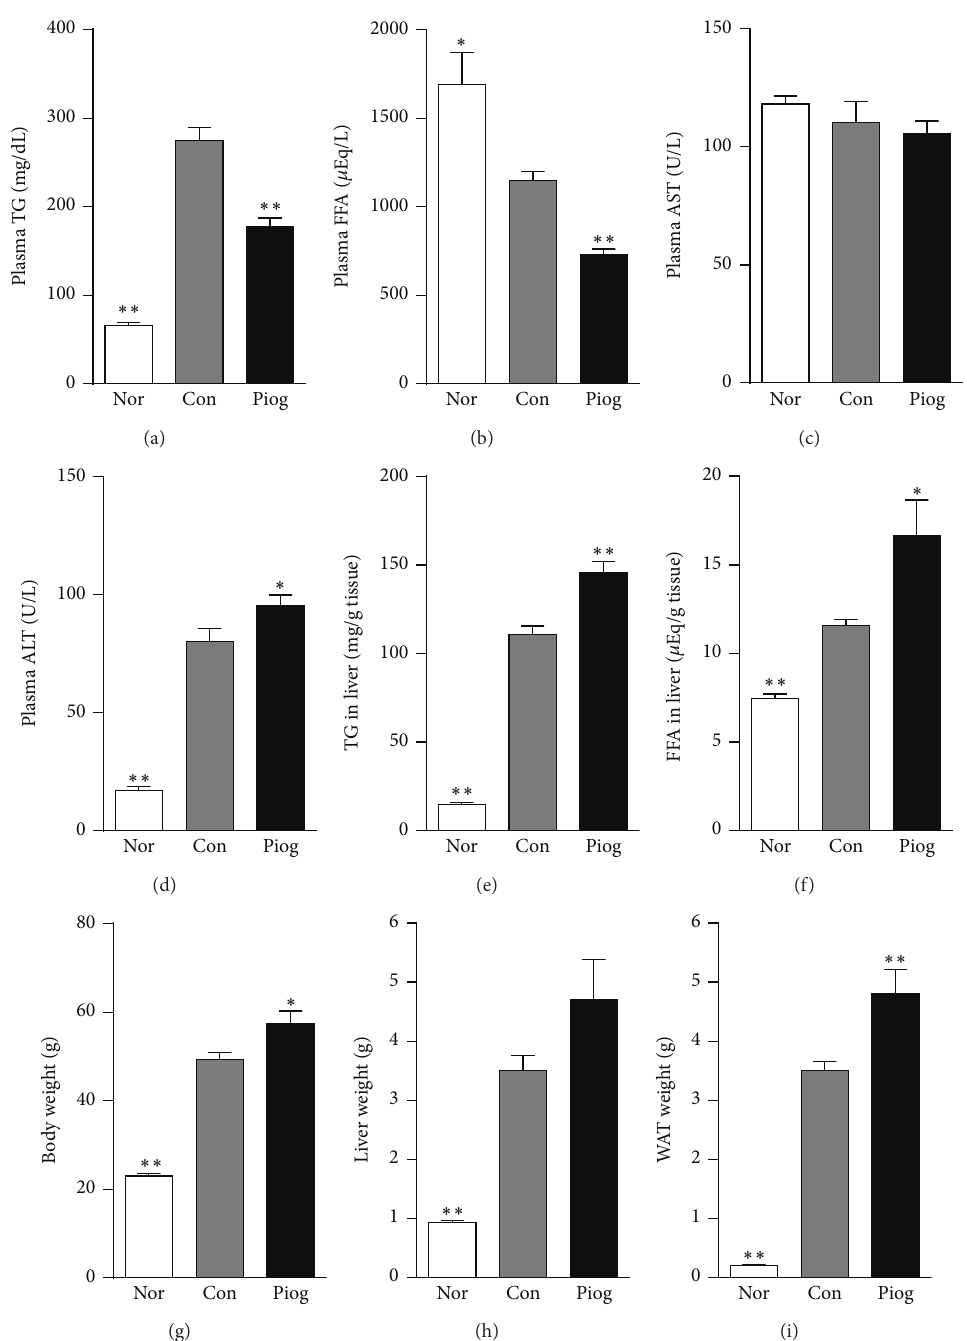
Figure 2: Effects of pioglitazone on biochemical variables involved in fatty acid metabolism and tissue weight in KKAy mice. The levels of plasma TG (a), plasma FFA (b), plasma levels of AST (c), plasma levels of ALT (d), liver TG (e), and FFA (f) were measured by commercial kits. The final body weight (g), liver weight (h) and WAT weight (i) were recorded at the end of the treatment. Nor, C57BL/6J mice; Con, vehicle-treated KKAy mice; Piog, pioglitazone-treated KKAy mice. Data are presented as mean ± S.E.M. ( 𝑛 = 10 per group). ∗ 𝑃 < 0.05 , ∗∗ 𝑃 < 0.01 versus